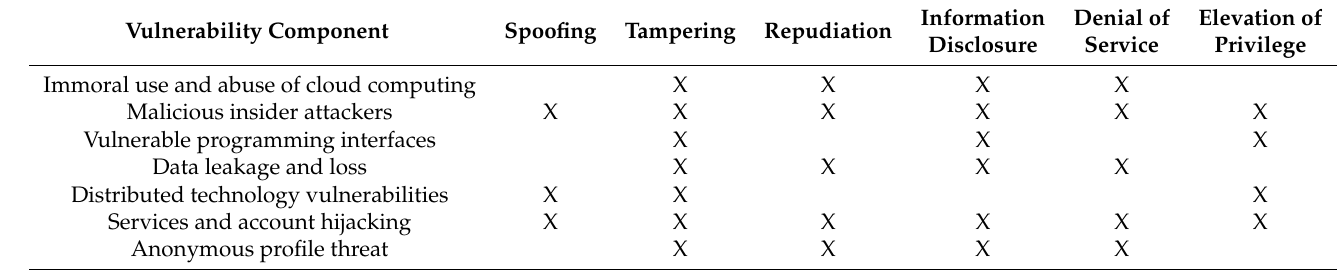
Table 7. Cloud computing security vulnerabilities using